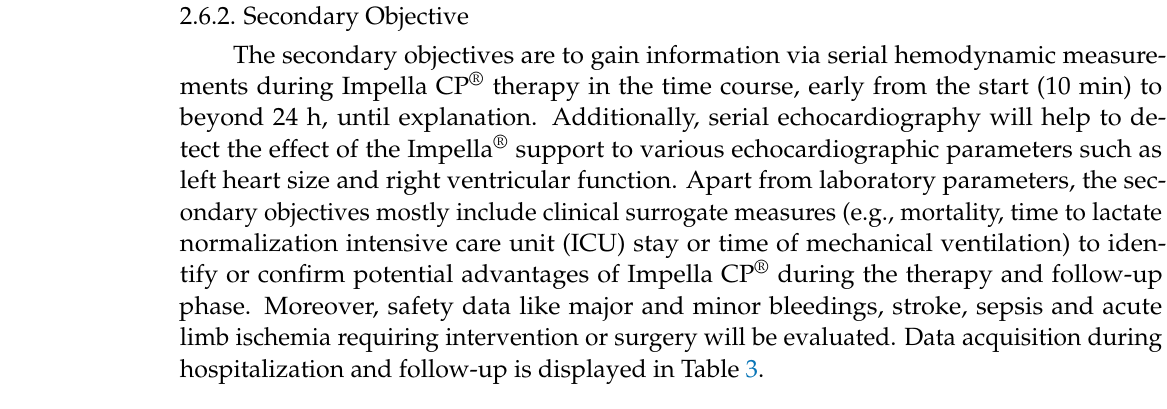
Table 3. Frequency and scope of the JenaMACS study